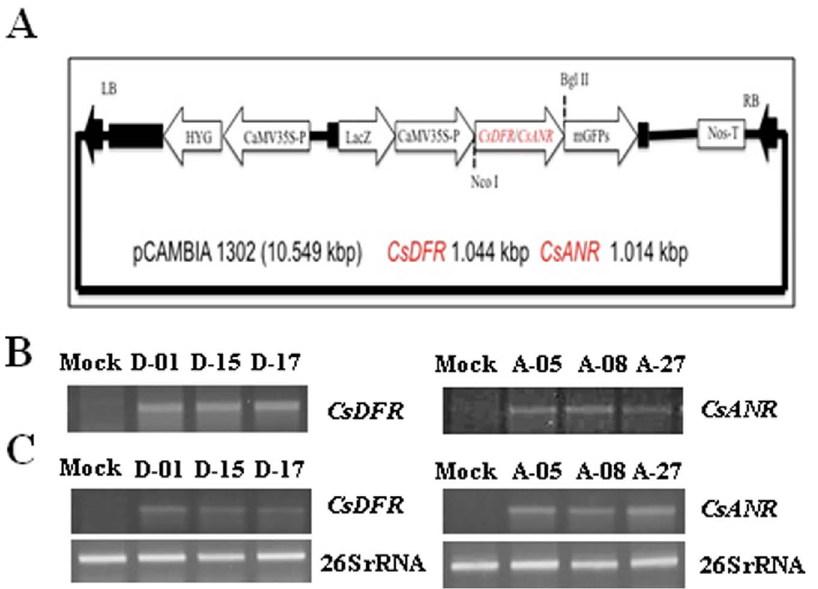
Figure 2. Generation of CsDFR and CsANR transgenic tobacco. A, Graphic representation of pCAMBIA 1302 vector with cDNA of CsDFR and CsANR . CsDFR and CsANR cDNA was inserted in-between the NcoI and BglII restriction site of pCAMBIA 1302. B, Genomic DNA PCR confirmed the insertion of CsDFR and CsANR cDNA in plant genome of transgenic lines. C, Semi-quantitative PCR documented the transcript expression levels of CsDFR and CsANR in transgenic tobacco lines. Housekeeping gene 26S rRNA was used as internal control for expression study and experiments were repeated at least three times with similar results.